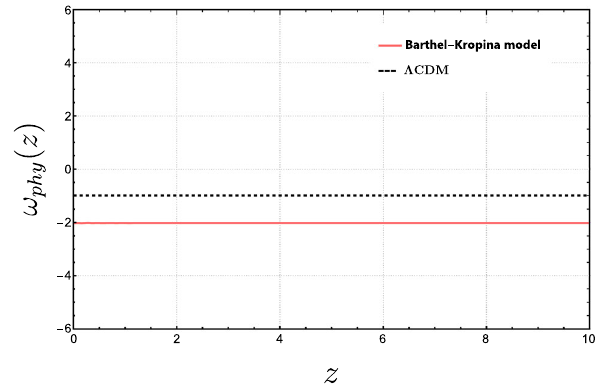
Fig. 14 The evolution of the equation of state parameter ω phys as a function of the redshift z